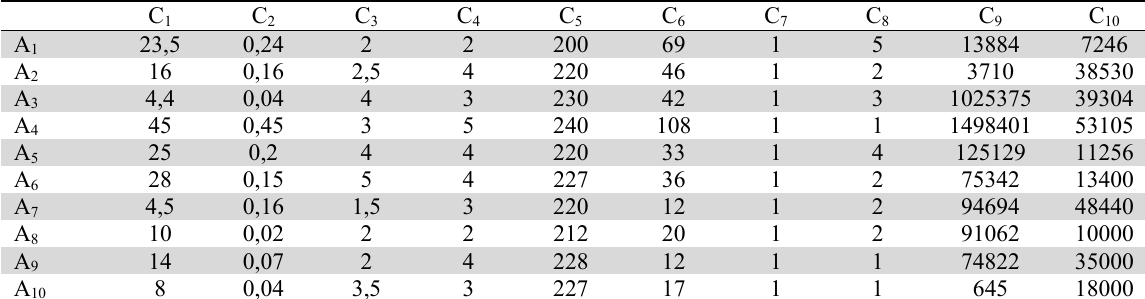
Criteria data of TPL providers